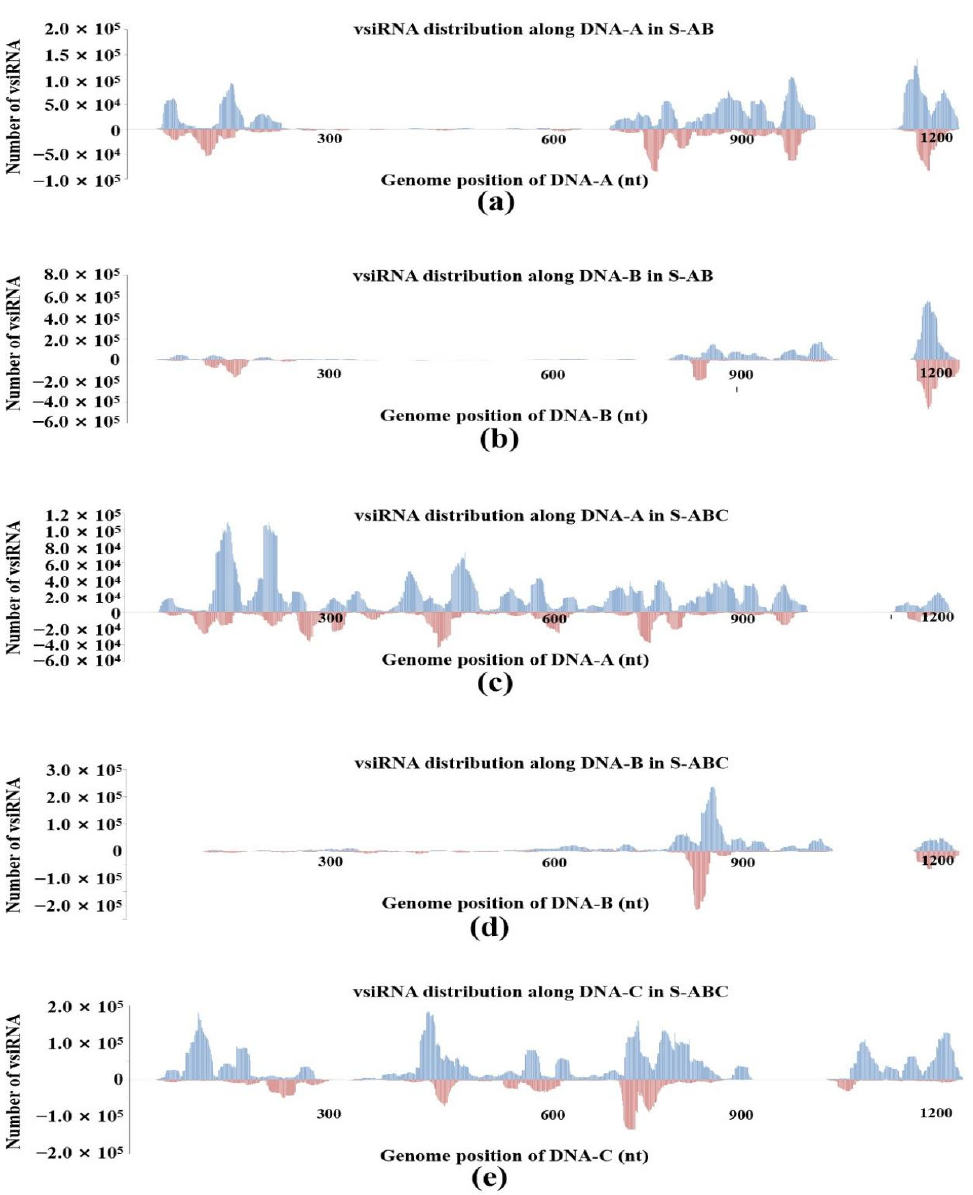
Figure 3. VsiRNA genome mapping on different segments of FgGMTV1 in S-AB and S-ABC. ( a ) vsiRNA from S-AB mapping along DNA-A. ( b ) vsiRNA from S-AB mapping along DNA-B. ( c ) vsiRNA from S-ABC mapping along DNA-A. ( d ) vsiRNA from S-ABC mapping along DNA-B. ( e ). vsiRNA from S-ABC mapping along DNA-C. The abundance of reads matching the positive strand is represented by the blue bar, whereas the abundance of reads mapping to the negative strand is represented by the red bars. Genomic coordinates are shown on the x-axis and the point cumulative abundance of all reads is shown on the y axis. S-S (virus-free strain), S-AB (S-S strain infected with DNA-A and DNA-B segments of FgGMTV1), S-ABC (S-S strain infected with DNA-A, DNA-B and DNA-C segments of FgGMTV1).